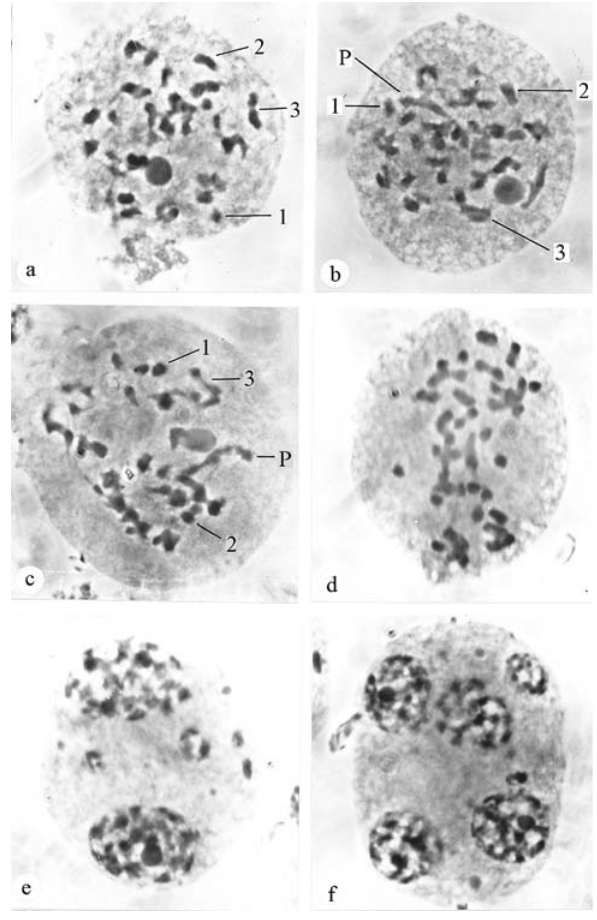
Figure 3 - Microsporogenesis in Eupatorium laevigatum . Key: a, b, c = Diakinesis showing univalents (1) bivalents (2), trivalents (3) and higher polyvalents(P);d=AnaphaseIwithlaggingchromosomes;e,f=Firstand second divisions with micronuclei. Magnification: a = 1450x; b, c = 1350x; d, e = 1500x; f = 1600x.